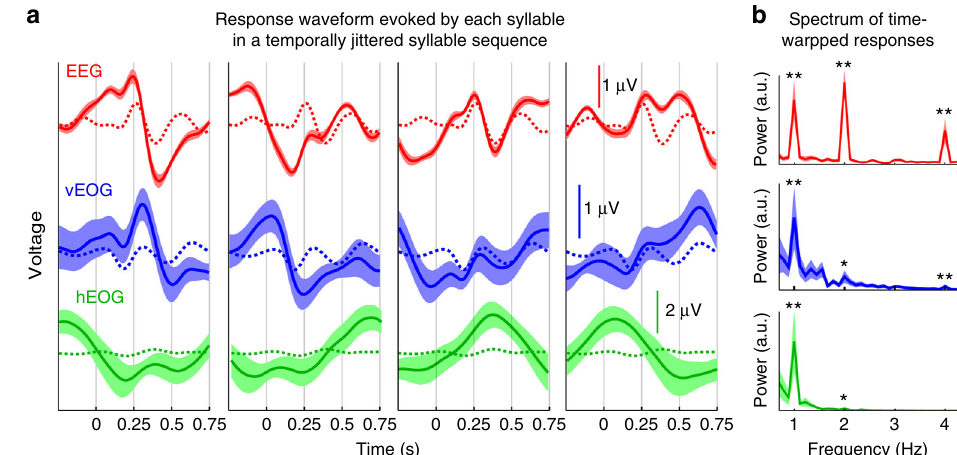
Fig. 8 EOG and EEG tracking of sentences for temporally jittered syllables. a EEG and EOG responses to each of the four syllables in a sentence. The response is averaged over sentences and participants, and the shaded area covers 1 SEM. The dotted curve shows the response averaged over all four syllables. b The response to temporally jittered syllables is time warped to simulate the response to an isochronous syllable sequence. The spectrum of the simulated response shows a peak at the sentential rate for EEG, vertical EOG, and horizontal EOG. See Supplementary Table 8 for the exact P -value, mean, and variance measures. * P < 0.05; ** P <